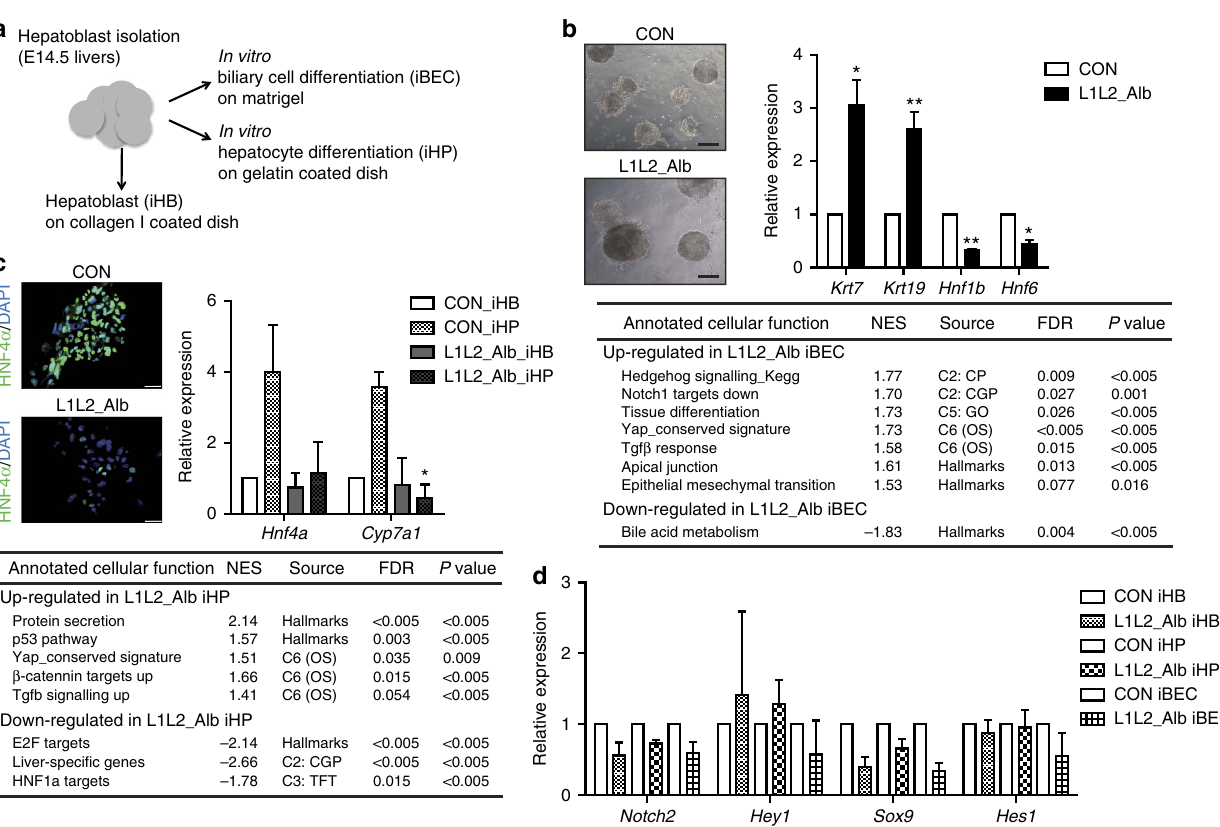
Figure 1 | Lats1/2 -deficient hepatoblasts strongly differentiate into BECs but not hepatocytes. ( a ) In vitro culture system schematic. ( b ) Representative bright-field images of BECs obtained from control and L1L2_Alb hepatoblasts subjected to in vitro differentiation for 14 days (upper). Scale bars, 400 m m. The graph shows the mRNA expression levels of cytokeratins 7 and 19 in control and L1L2_Alb iBECs, as assessed by qRT-PCR. The box shows up-regulated or down-regulated gene sets from the RNA-sequencing results with control and L1L2_Alb iBECs. ( c ) Representative immunofluorescence staining with anti- HNF4 a (left) and relative mRNA expression levels of Hnf4 a and Cyp7a1 in control and L1L2_Alb iHBs and iHPs, as assessed by qRT-PCR (right). Scale bars, 50 m m. The box shows up-regulated or down-regulated gene sets from the RNA-sequencing results with control and L1L2_Alb iHPs. ( d ) Relative expression levels of Notch signalling target genes in control and Lats1/2 -deficient iHBs, iHPs and iBECs. The data are presented as means ± s.e.m.; n ¼ 3 ( b , c ), * P o 0.05 and ** P o 0.01 (Student’s t